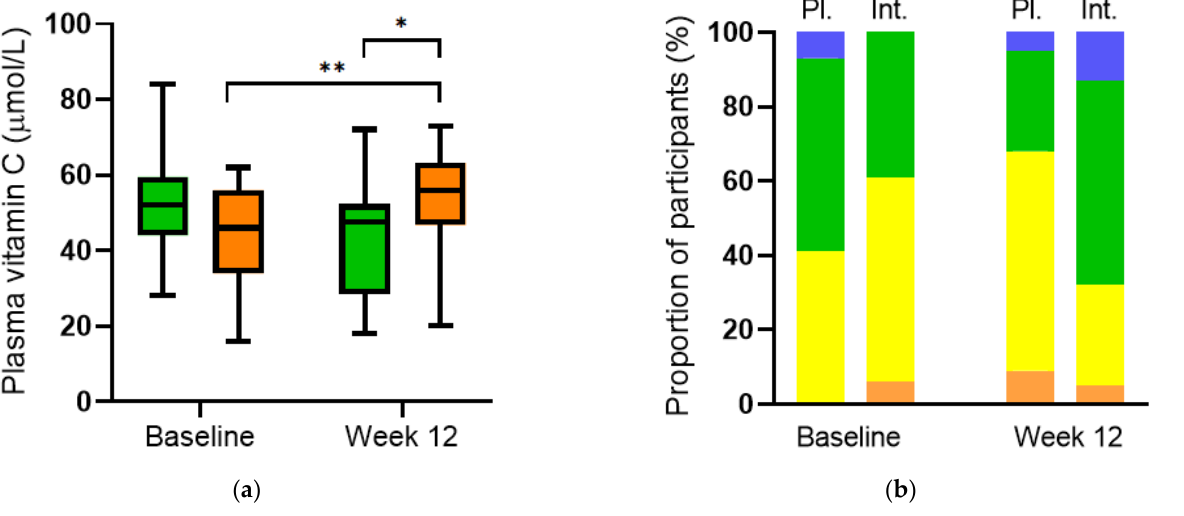
Figure 6. Vitamin C and C-reactive protein concentrations relative to body weight. ( a ) Inverse cor- relation between vitamin C status and weight ( r = − 0.287, p = 0.03). ( b ) Vitamin C status relative to median body weight (** p = 0.001). ( c ) Positive correlation between CRP and weight ( r = 0.501, p = 0.0001). ( d ) CRP concentration relative to median body weight (** p = 0.004). Dashed lines indicate 95% confidence intervals. Box plots represent median with 25th and 75th percentiles as boundaries, and whiskers indicate maximum and minimum values.